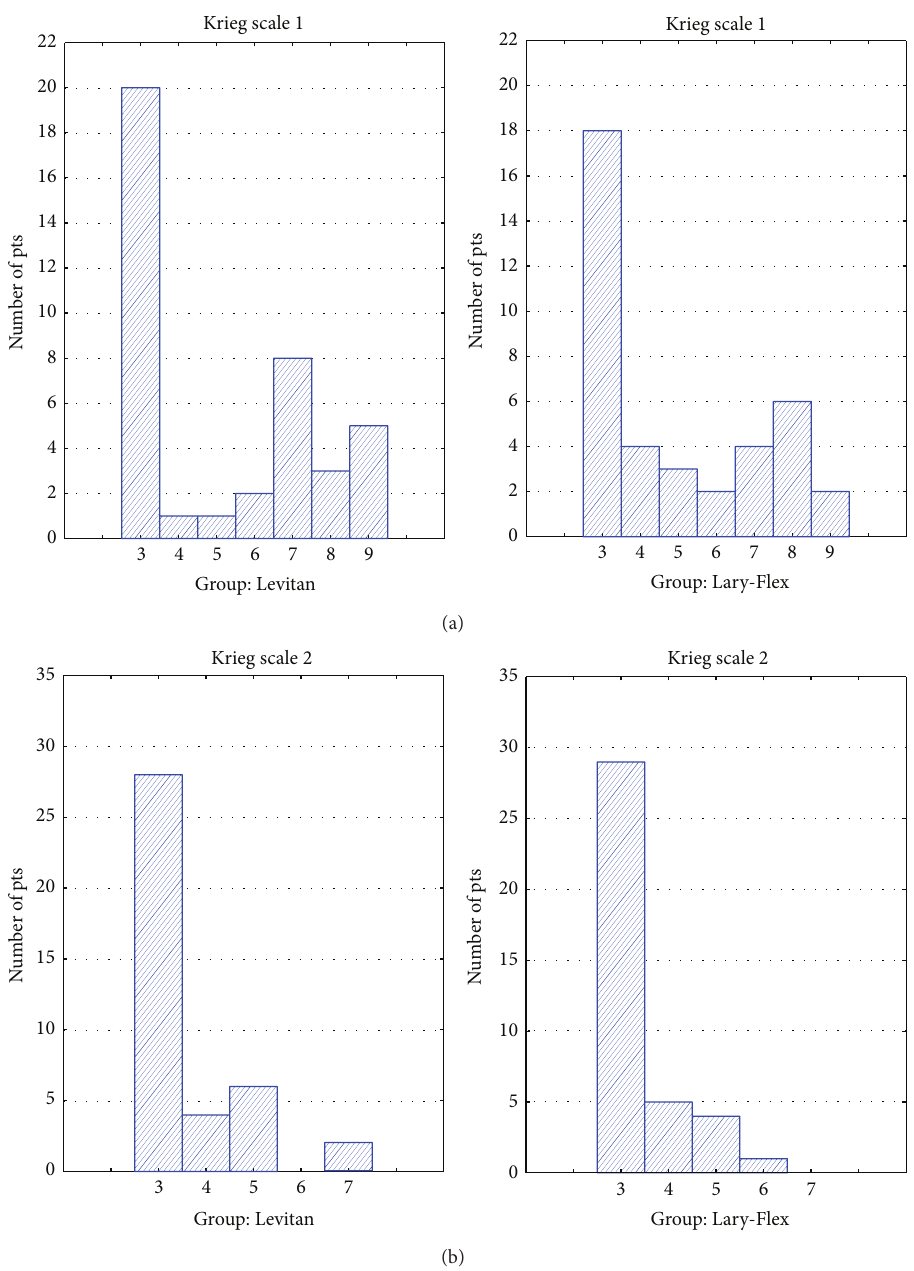
Figure 6: Histograms of evaluation of intubation conditions: Krieg scale 1, conditions using Macintosh blade laryngoscope (Levitan group) or Lary-Flex as standard laryngoscope (Lary-Flex group), Krieg scale 2, conditions using